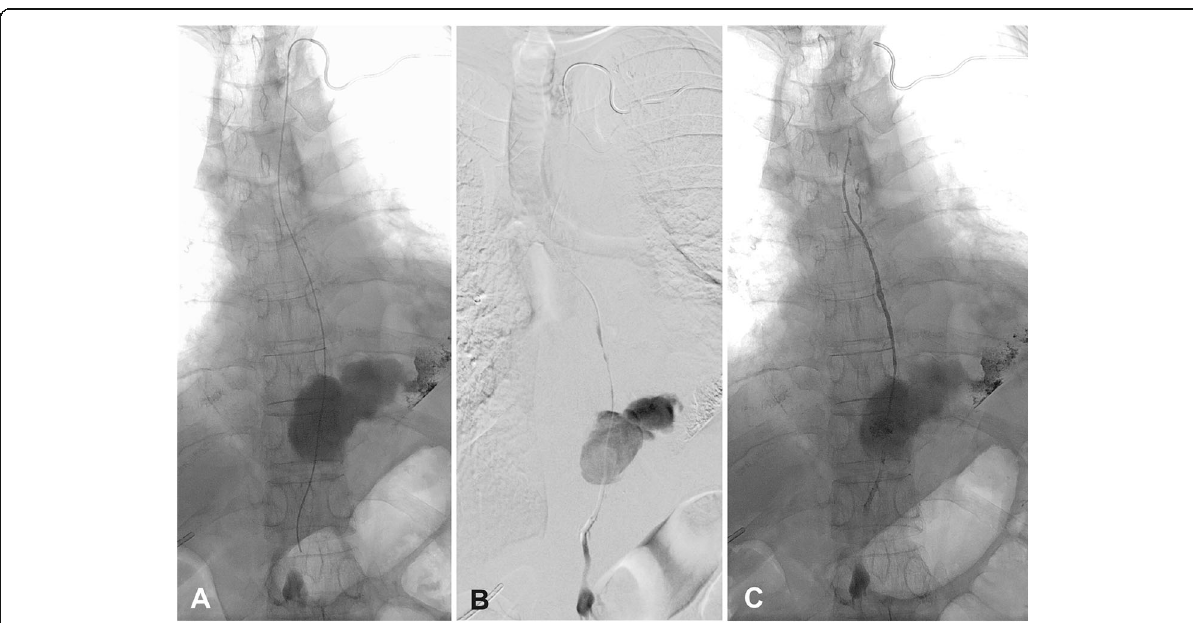
Fig. 4 Retrograde transvenous embolization of the thoracic duct. a Microcatheter in the proximal thoracic duct direct above the cisterna chyli with large chylous leakage at the T10 vertebral level including residual lipiodol-leakage from the transnodal lymphangiography performed few days before. b Same situation documented with digital-subtraction-angiography. c Situation after thoracic duct embolization with glue cast from direct above the cisterna chyli up to the distal thoracic